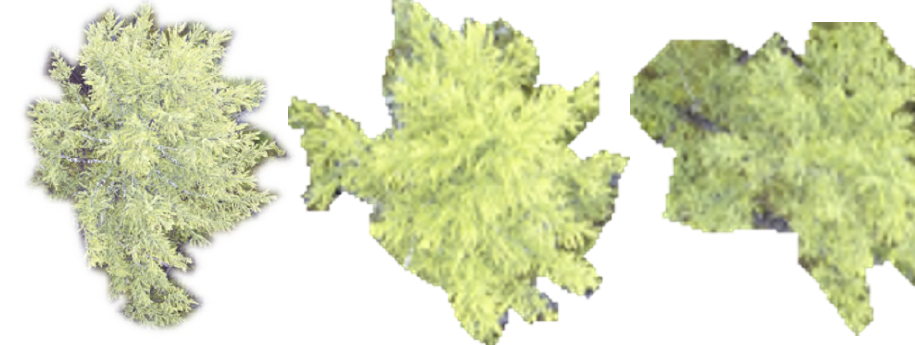
Figure 9. Examples of cutout tree crowns.